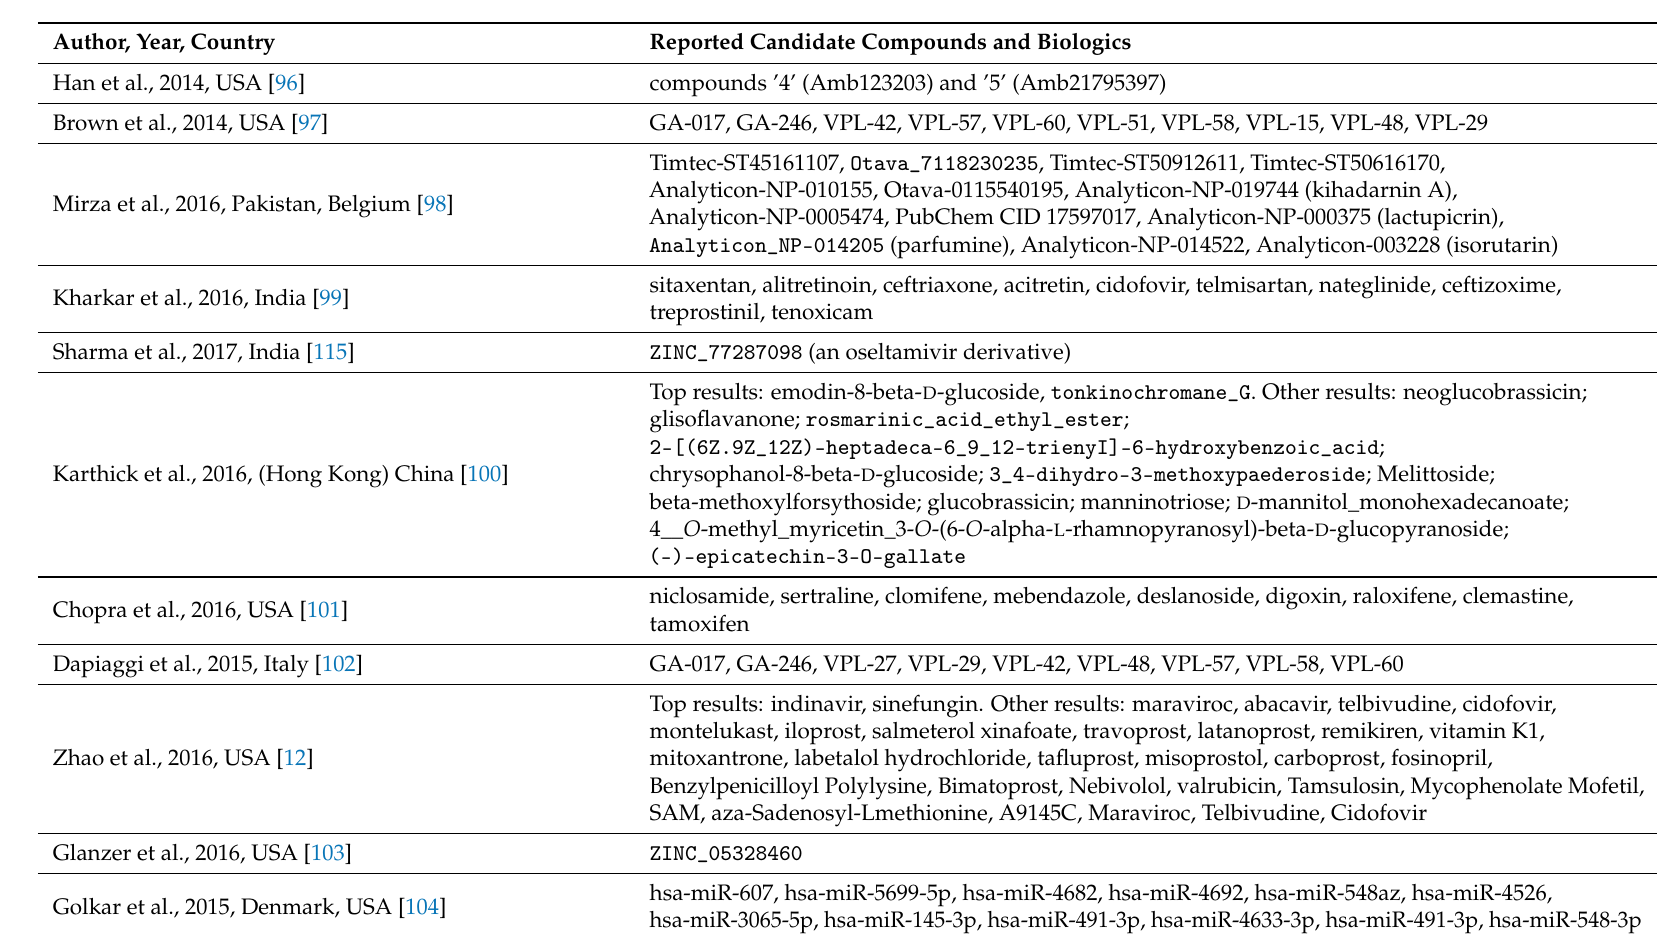
Table 3. A selection of the putative leads against Ebola reported in the studies reviewed. miRNAs (one study) and compound classes (two studies) are sometimes reported as leads. Some authors report self-labeled or unlabeled compounds. Compound identifiers are reported in a variety of different ways, including generic and commercial names, IUPAC terms, and PubChem, ZINC, PDB small molecule, Timtec, and Analyticon identifiers. A large set of putative leads is reported. Computational research can allow for researchers to investigate much larger sets of candidate compounds than traditional drug discovery